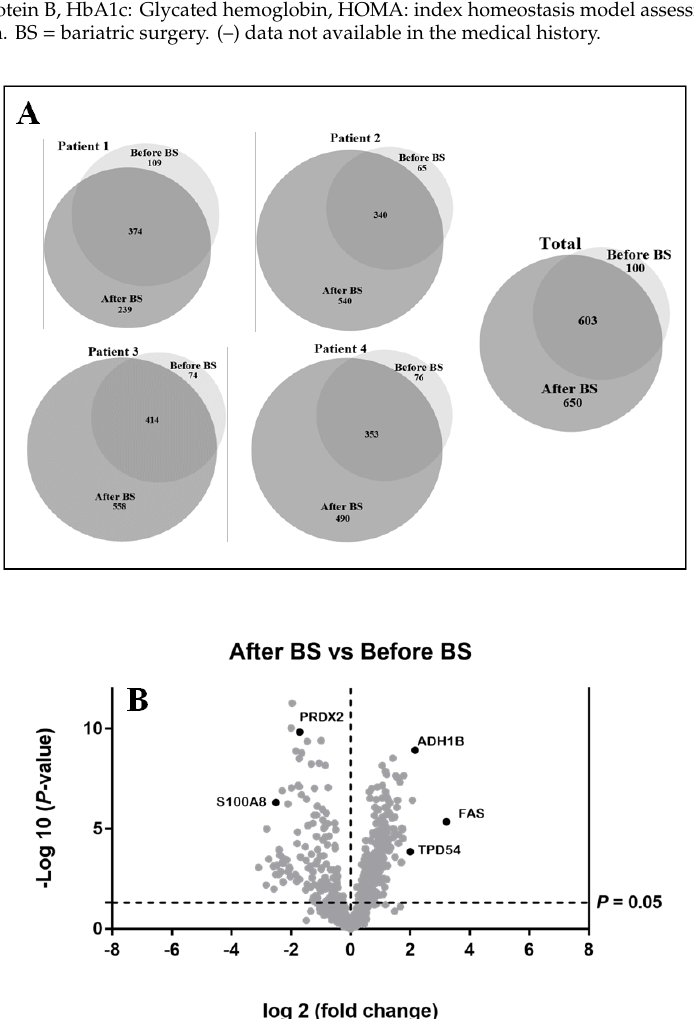
Figure 1. (A). Effect of obesity and bariatric surgery on protein expression in abdominal subcutaneous adipose tissue depot (aSAT). Venn diagrams showing the qualitative proteomic analysis of aSAT from four obese patients before bariatric surgery (before BS) and the same patients after body weight loss induced by bariatric surgery (after BS). They show the number of unique and overlapping proteins identified individually for each patient before and after bariatric surgery (Patient 1–4), as well as the total of proteins identified. (B) . Graphical representation of quantitative proteomics data. Proteins are ranked in a volcano plot according to their statistical p -value ( y -axis) and their relative abundance ratio (log2-fold change) between aSAT samples after BS and before BS ( x -axis). Off-centered spots are those that vary the most between both groups. The cut-offs for significant changes are fold-changes of 1.5 and p < 0.05.